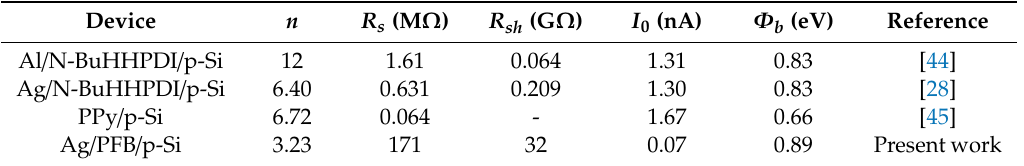
Table 3. Comparison of device parameters of the Ag / PFB / p-Si heterojunction with the previously reported heterojunction